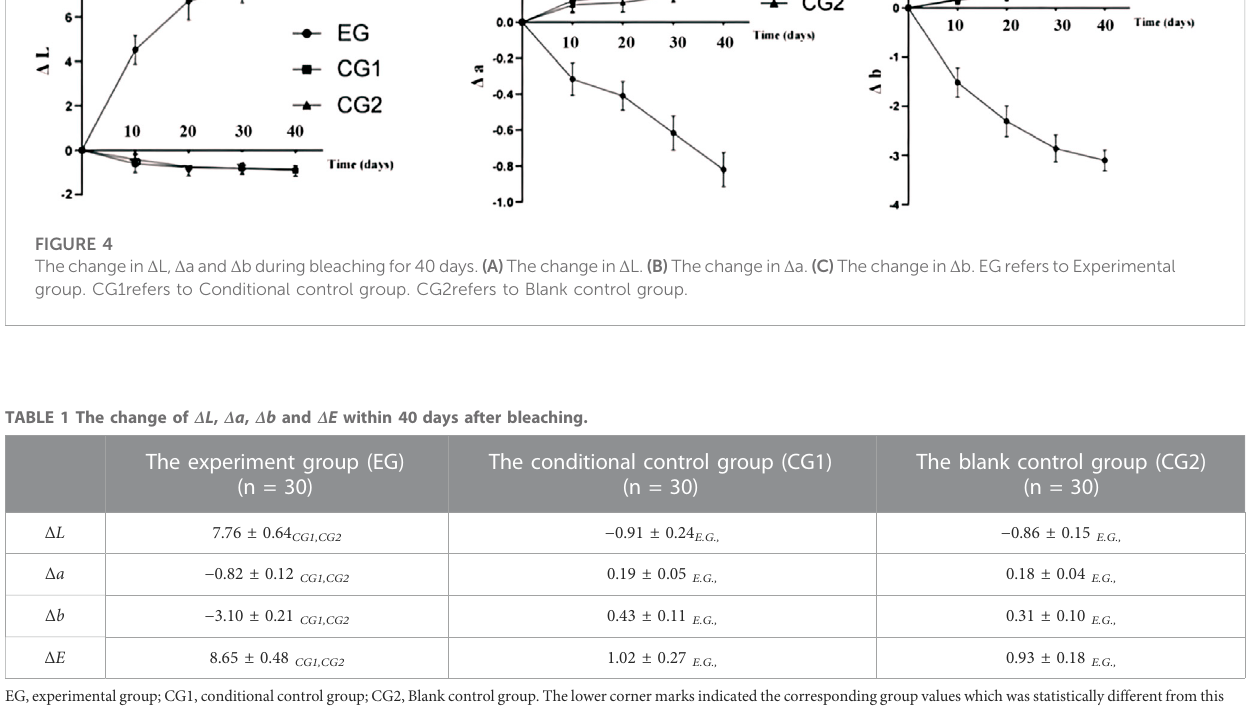
The conditional control group (CG1) (n = 30)